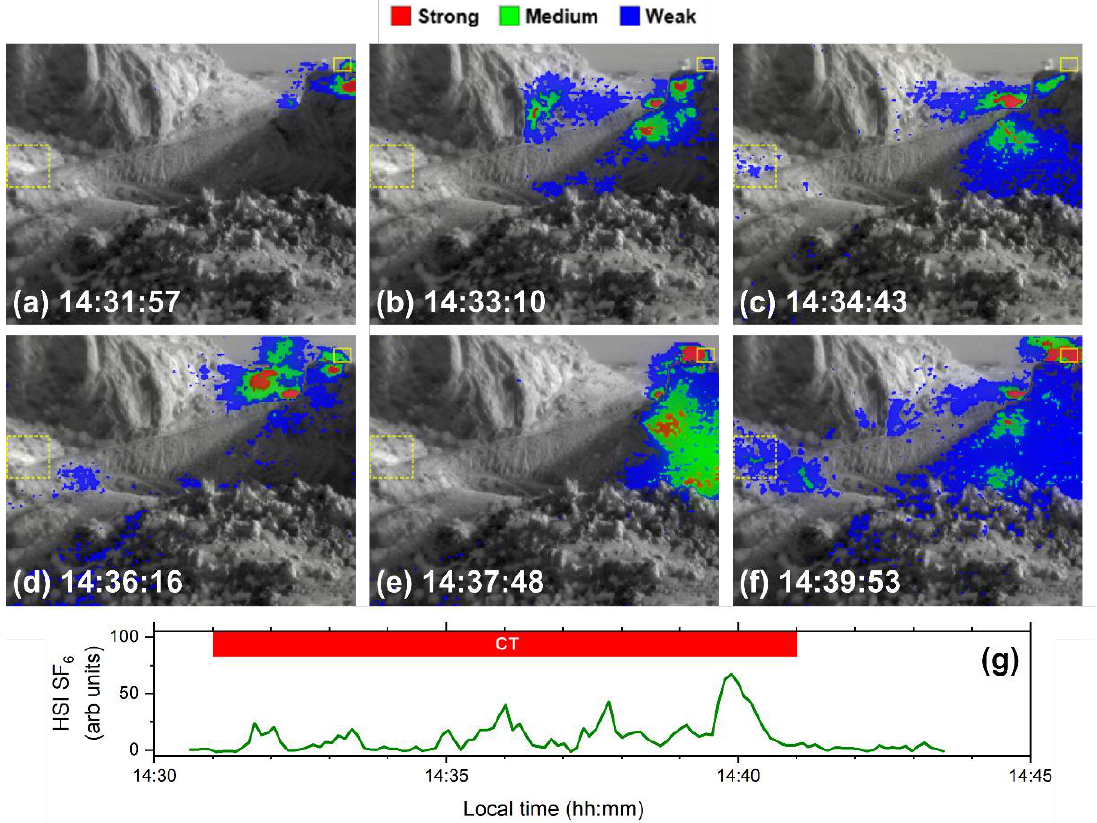
Figure 7. Plume detection using LWIR-HSI system during a release of SF 6 from the CT location. ( a – f ) Images of detected SF 6 at selected times. The dashed box shows the location of the retroreflector. Color mapping blue (weak), green (medium), and red (strong) shows relative HSI signal strength between zero and maximum, divided into three equal bins. ( g ) SF 6 signal versus time averaged over the region in the solid rectangle. The solid red bar shows the times over which SF 6 was released.